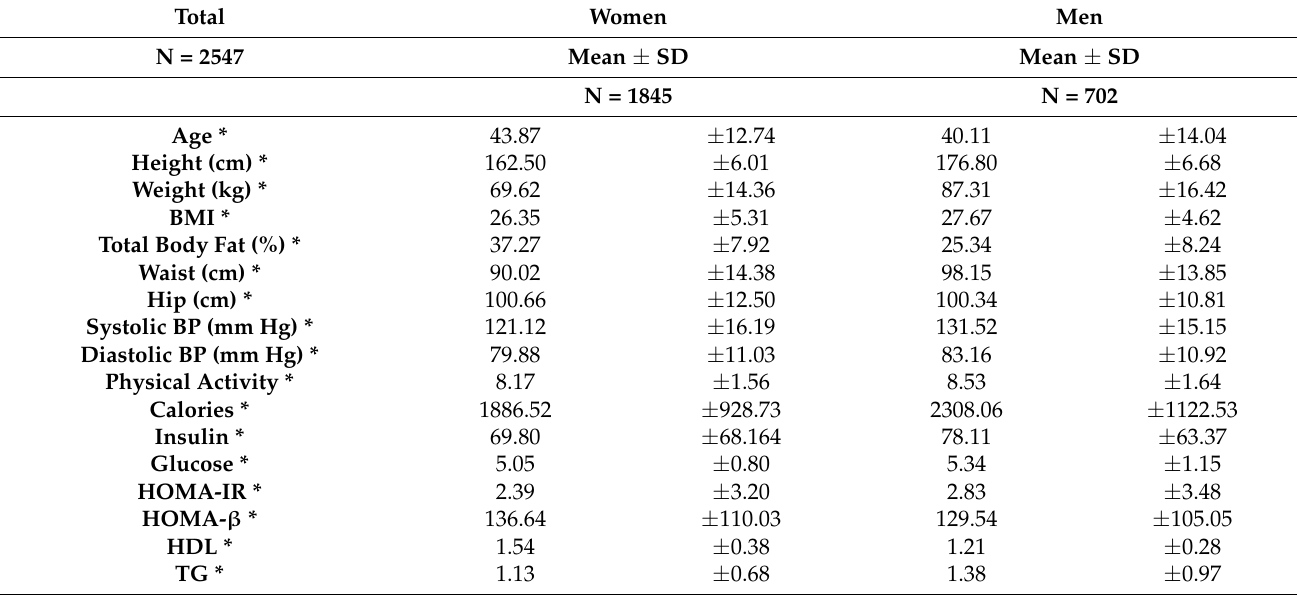
Table 1. Physical and metabolic characteristics of men and